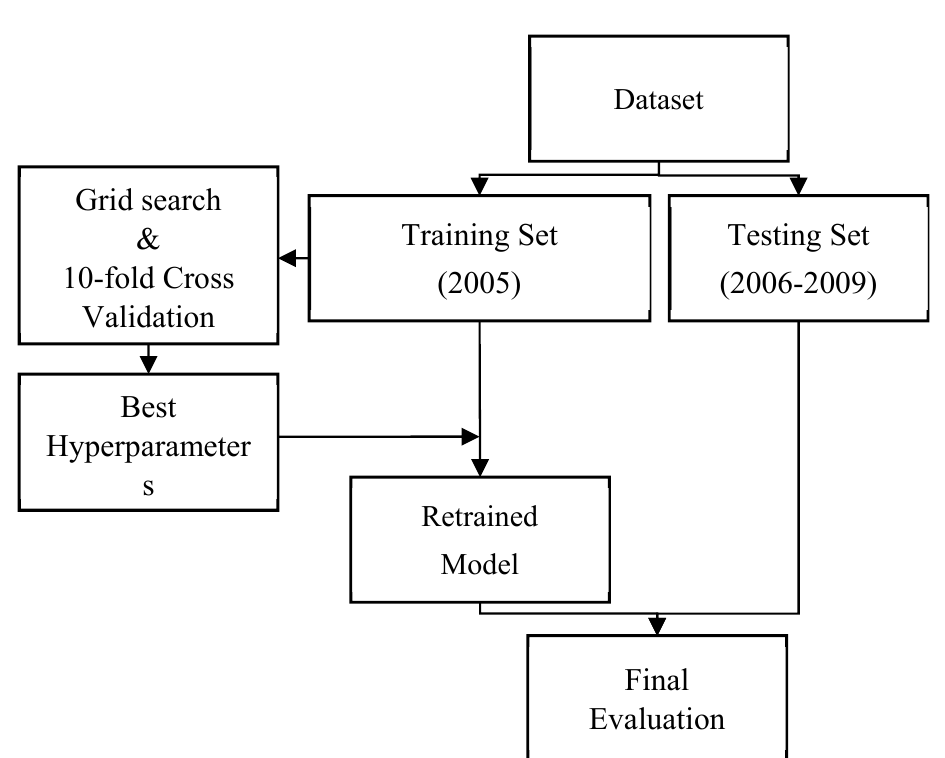
Figure 4. The flowchart in RF CSD model training and